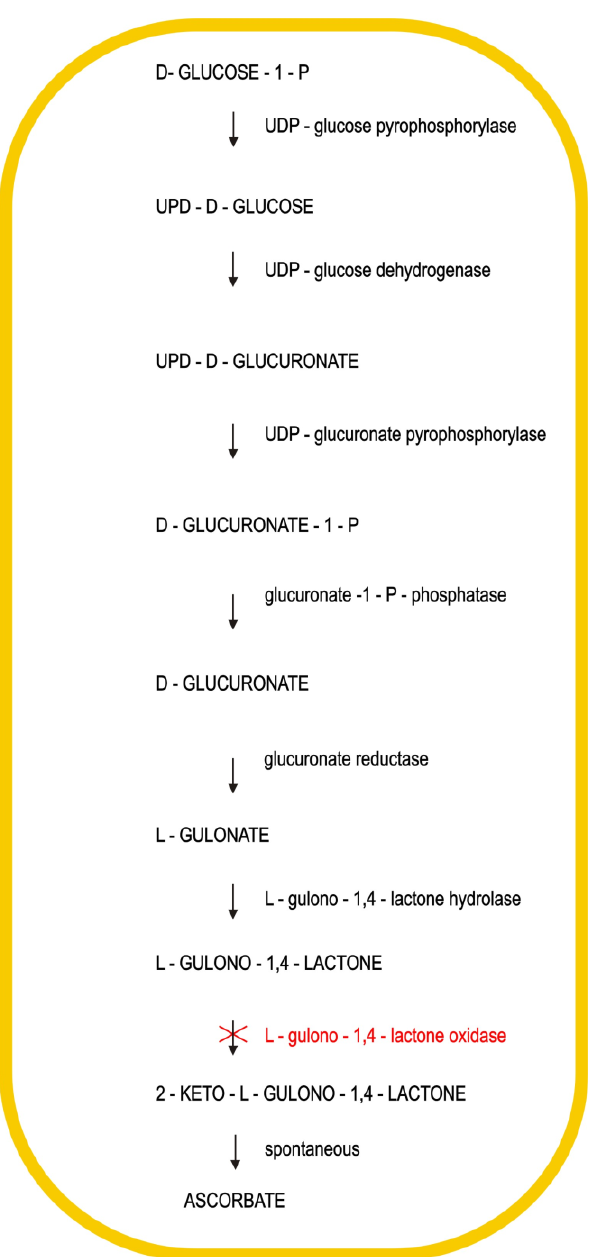
Figure 2. Vitamin C synthesis. The enzyme L -gulono-1,4-lactone oxidase is missing in humans and prevents them from producing ascorbic acid from glucose.